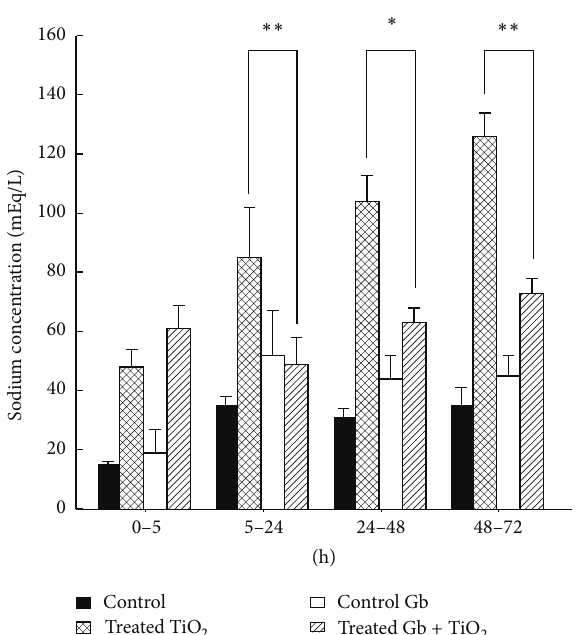
Figure 4: The effects of GbE on the renal effects of TiO 2 of the urinary sodium concentration, at different time periods, compared with control, GbE, and TiO 2 -treated rats. The sodium concentration is presented as mEquivalents of Na + /liter. The significance levels are: ∗ 𝑃 < 0.05 , ∗∗ 𝑃 < 0.01 .